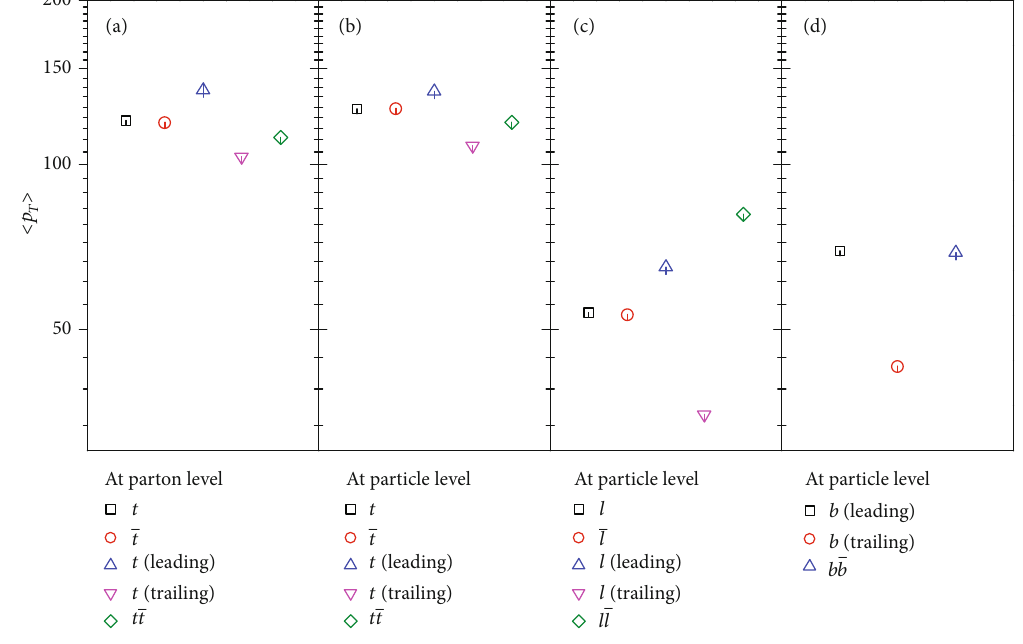
i for di ff erent particles. T